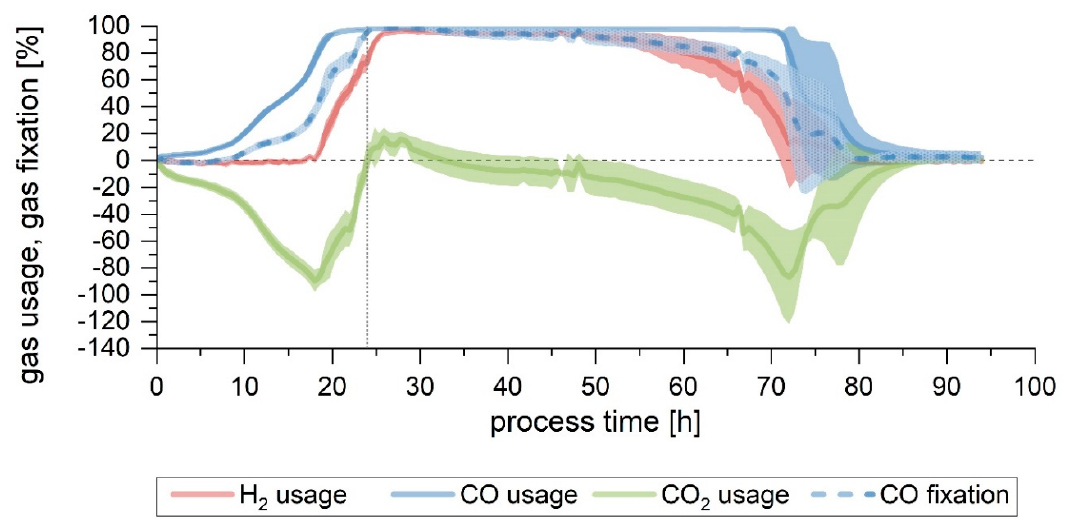
Figure 6. Substrate usage or fixation for Setup 6, where pH was allowed to drop to 4.8 and gas flow was decreased to 12.6 mL/min after 24 h (grey dotted vertical line). Usage is shown for H 2 (red line), CO 2 (green line) and CO (blue line). CO fixation is depicted by the dotted blue line. The calculated difference between amount of substance flow rate fed into the bioreactor and the amount of substance flow rate detected in the off-gas is shown here as a percentage. For the CO fixation, if the CO 2 usage was negative, the amount of CO 2 produced was subtracted from the amount of (perceived) CO used. Lines show the average of the triplicate ( n = 3), while the lighter colored areas depict the standard deviation.